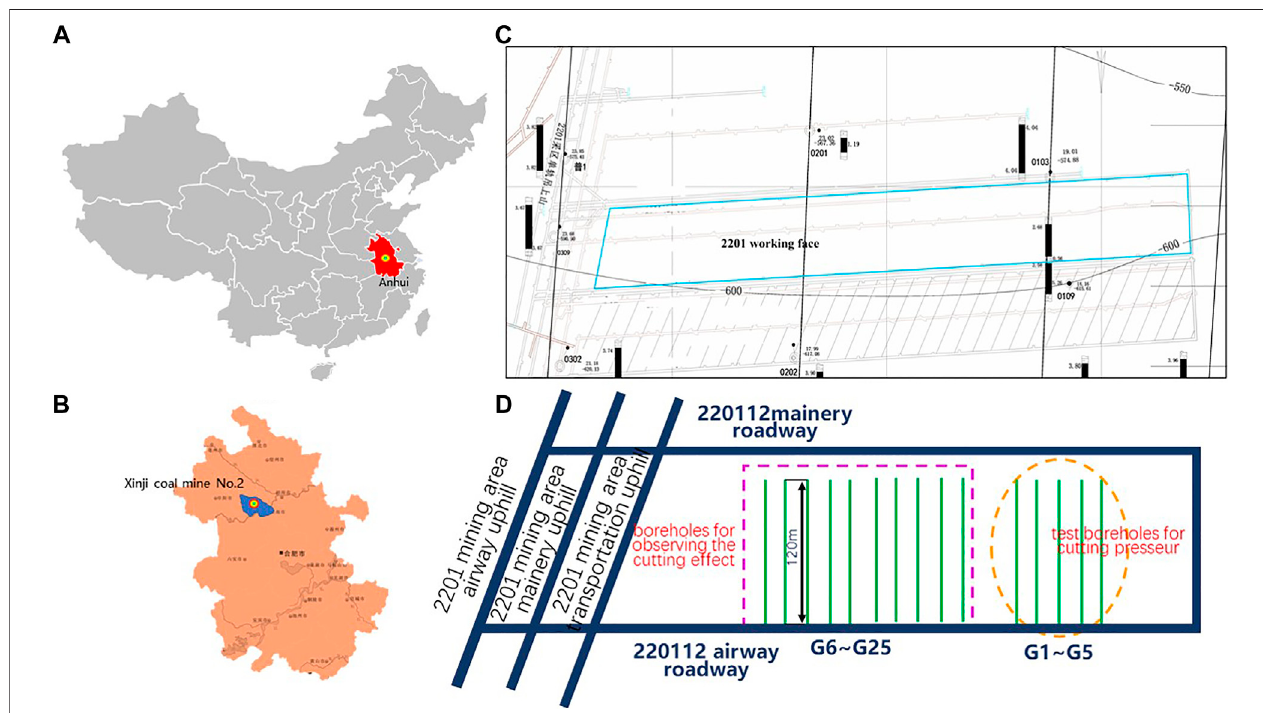
FIGURE 8 | Test positions; (A) the position in Anhui Province; (B) the position of the Xijin coal mine No. 2; (C) test positions; (D) distribution of test boreholes.